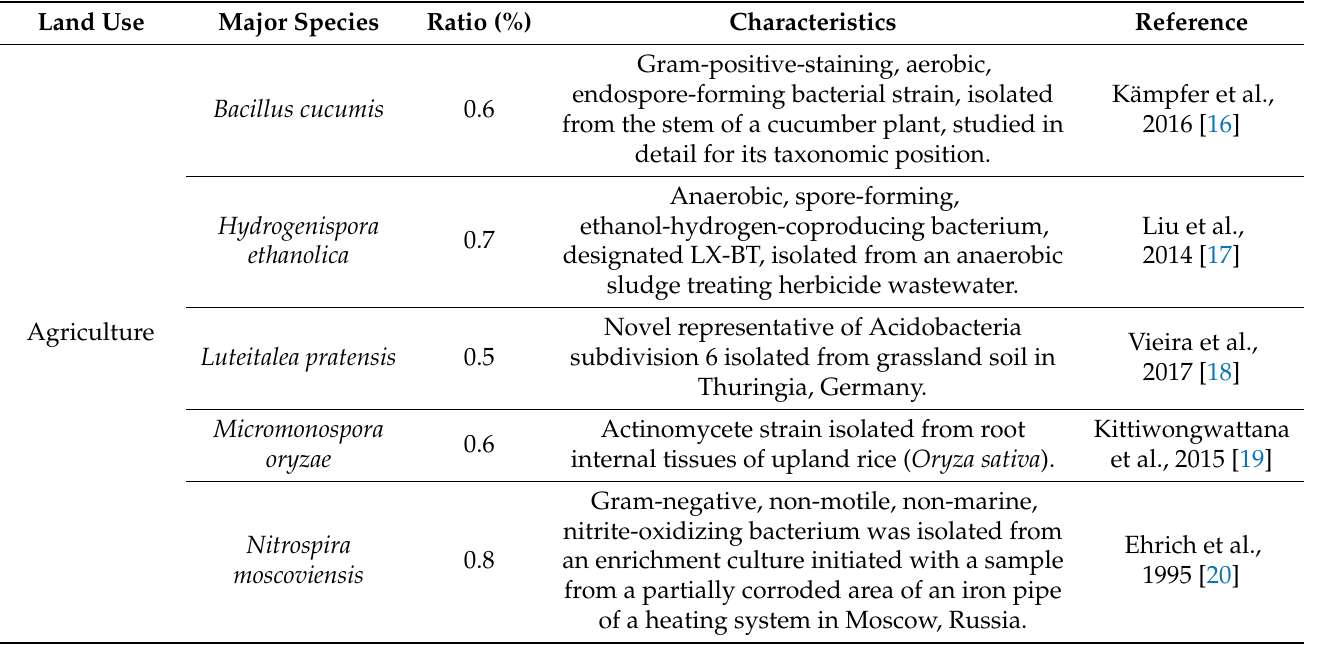
Table 4. Dominating species in surface soil in agriculture and forest land use